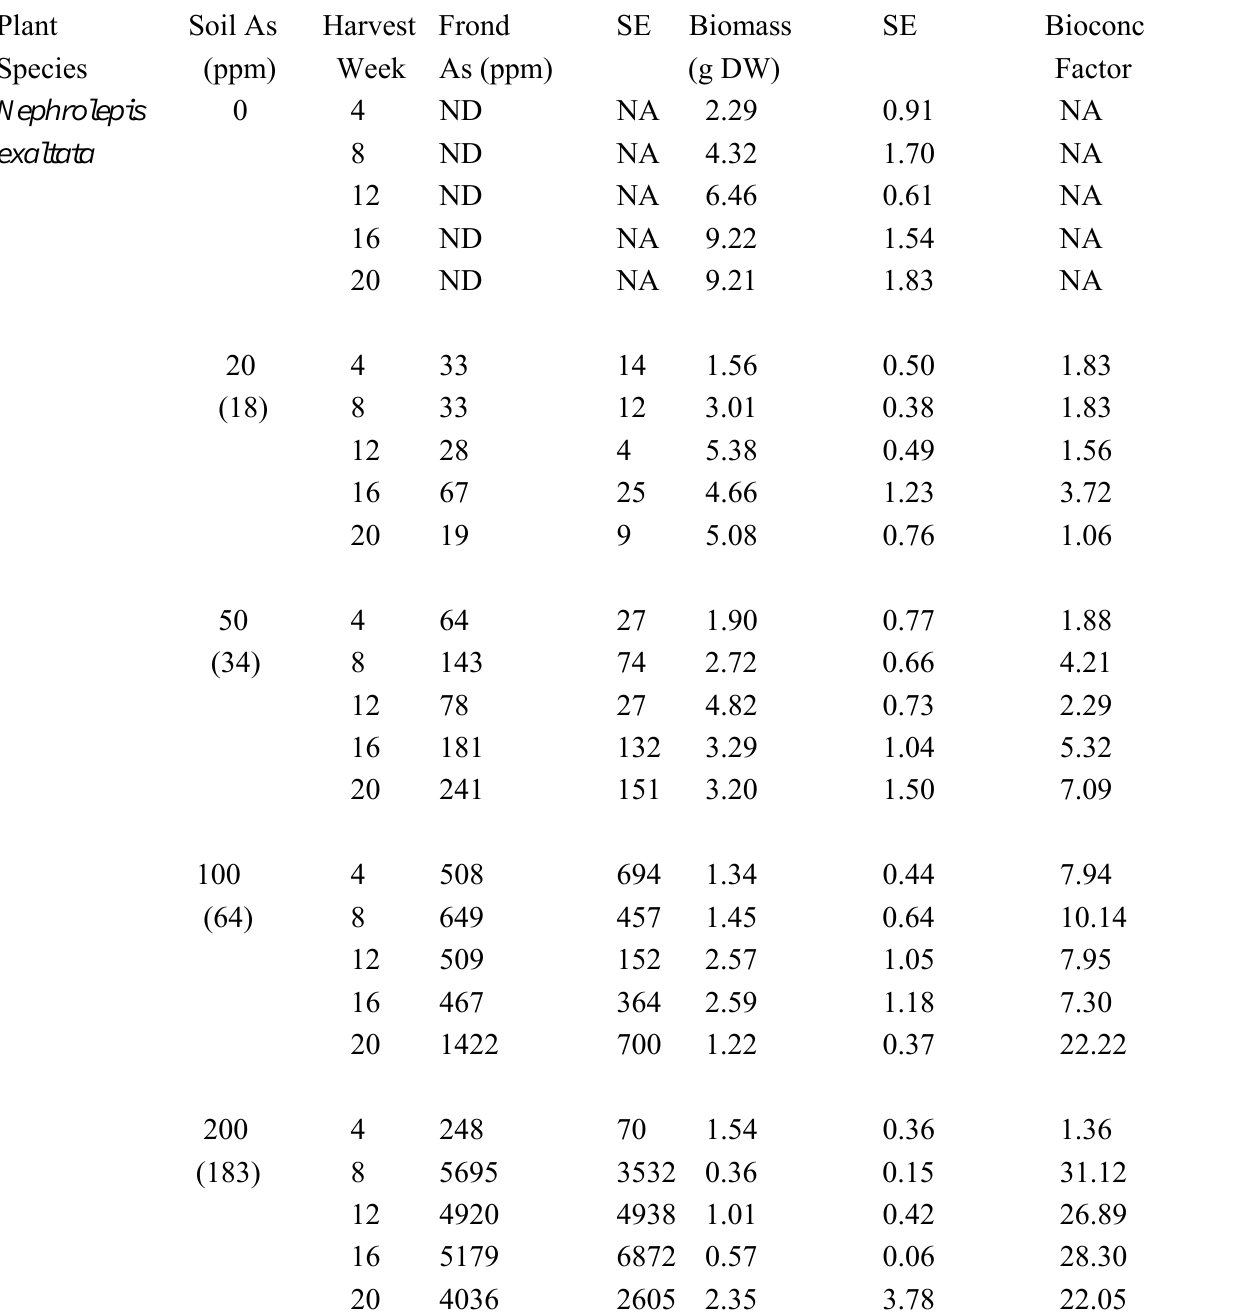
Table 1. Summary Results for Arsenic Uptake in Nephrolepis exaltata. SE is the standard error. Soil As lists predicted concentration and actual concentration in